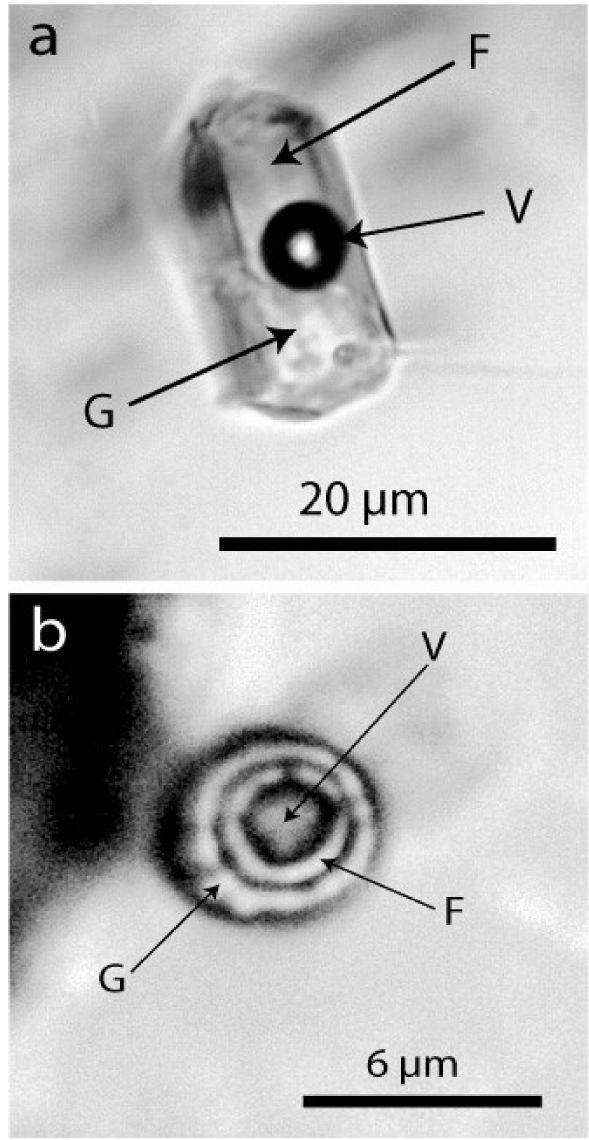
Figure 9. Water-rich melt inclusions in dravite. The inclusion ( a ) represents a typical volatile-rich melt inclusion, and ( b ) is a supercritical melt inclusion (see [29]. F—water-rich fluid phase, G—glass (often partially crystallized), V—vapor